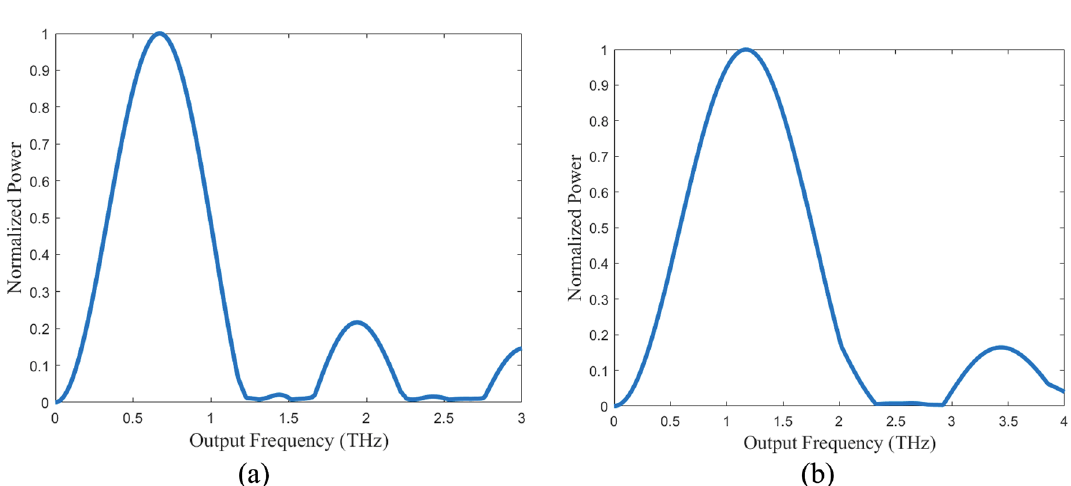
Figure 5. Simulated frequency spectra for the modified rotating dipole model. ( a ) Frequency spectrum of the simulated 0.5 THz system. A peak emission is observed at 0.67 THz. ( b ) Frequency spectrum of the simulated 1 THz system. A peak emission is observed at 1.17